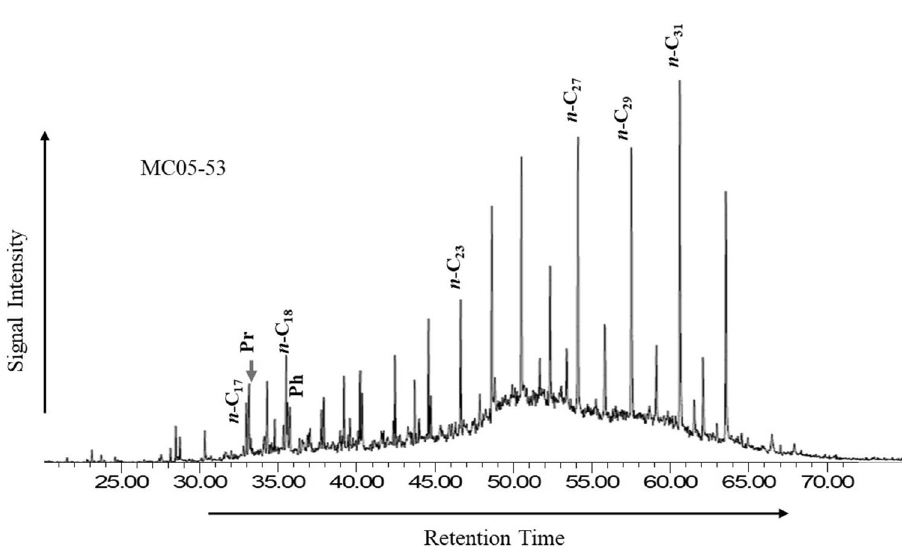
Figure 7. Example of n -alkanes ( m/z 85) distribution of the studied Mukah coals. Numbers represent the carbons in n -alkanes